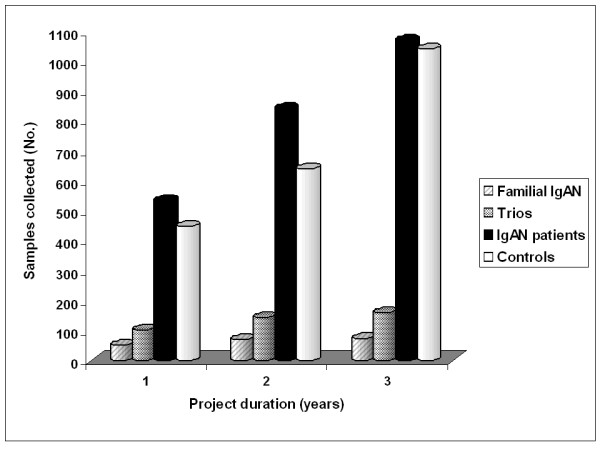
DNA samples collected from the beginning of the IgAN Consortium European project.